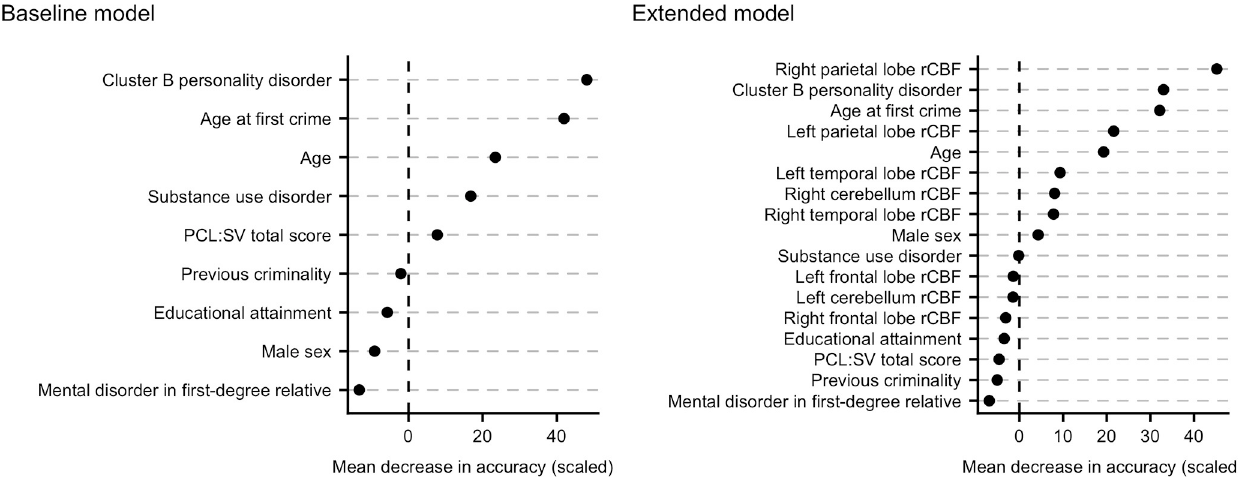
Fig 2. Variable importance. Variable importance measured as the scaled mean decrease in accuracy of each variable in the Baseline and Extended model. A higher value confers a higher decrease in the accuracy of the model, should that variable be omitted.